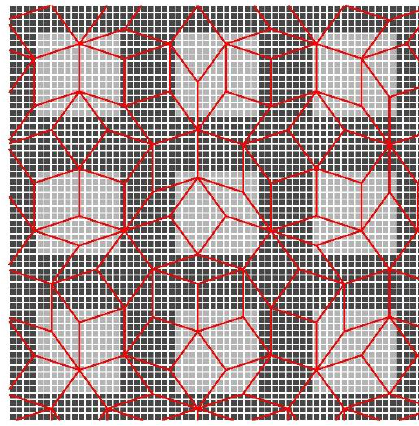
Figure 6. An example of the rhombus Penrose tiling.